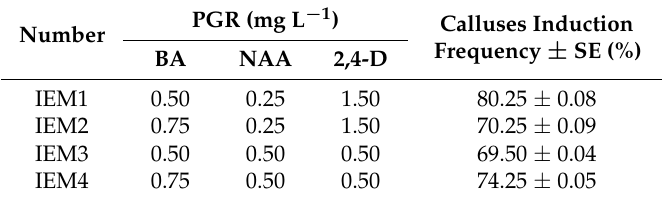
Effects of 6-benzylaminopurine (6-BA), 1-naphthaleneacetic acid (NAA), and